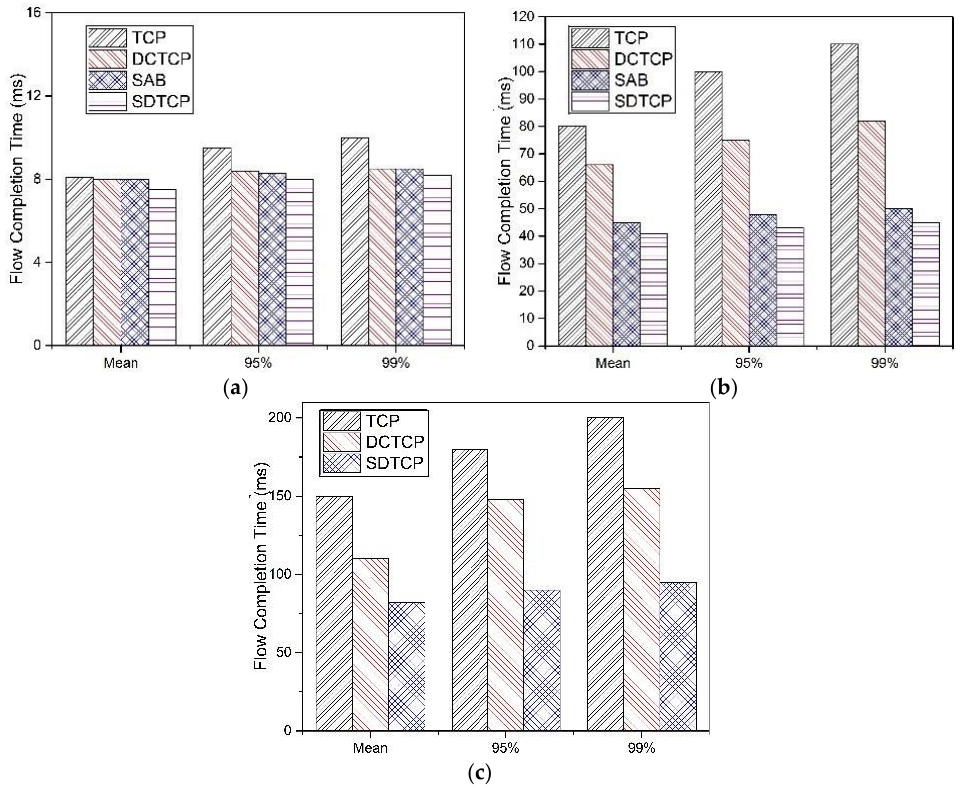
Figure 13. Mean, 95th, and 99th percentile FCT with different concurrent number of flows: ( a ) N = 10; ( b ) N = 50; and ( c ) N = 100. Sensors 2017 , 17 , 109